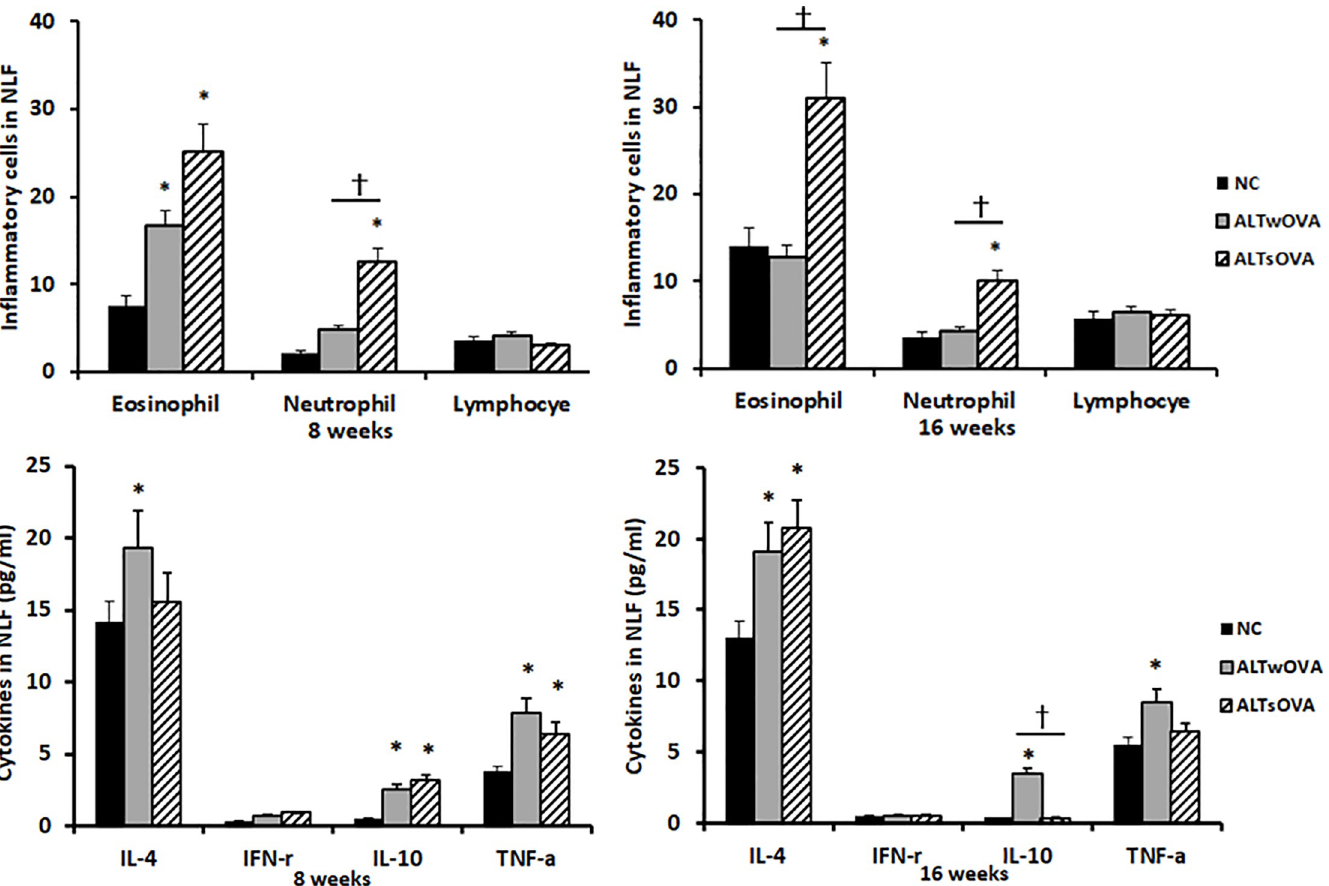
Fig 3. Inflammatory cell differentials and chemical mediator levels in Nasal Lavage Fluid (NLF) of the Alternaira induced chronic rhinosinusitis mouse model. Eosinophil and neutrophils were increased in NLF of non-allergic mouse model. Th2, Treg, and inflammatory cytokine revel were strongly expressed in NLF of allergic mouse model (n = 7 mice per group). NC: negative control, ALTwOVA: Alternaria instillation with ovalbumin (OVA) presensitization, ALTsOVA; Alternaria instillation without ovalbumin (OVA) presensitization. � p < 0.05 vs NC group, †p < 0.05 vs with or without OVA group.